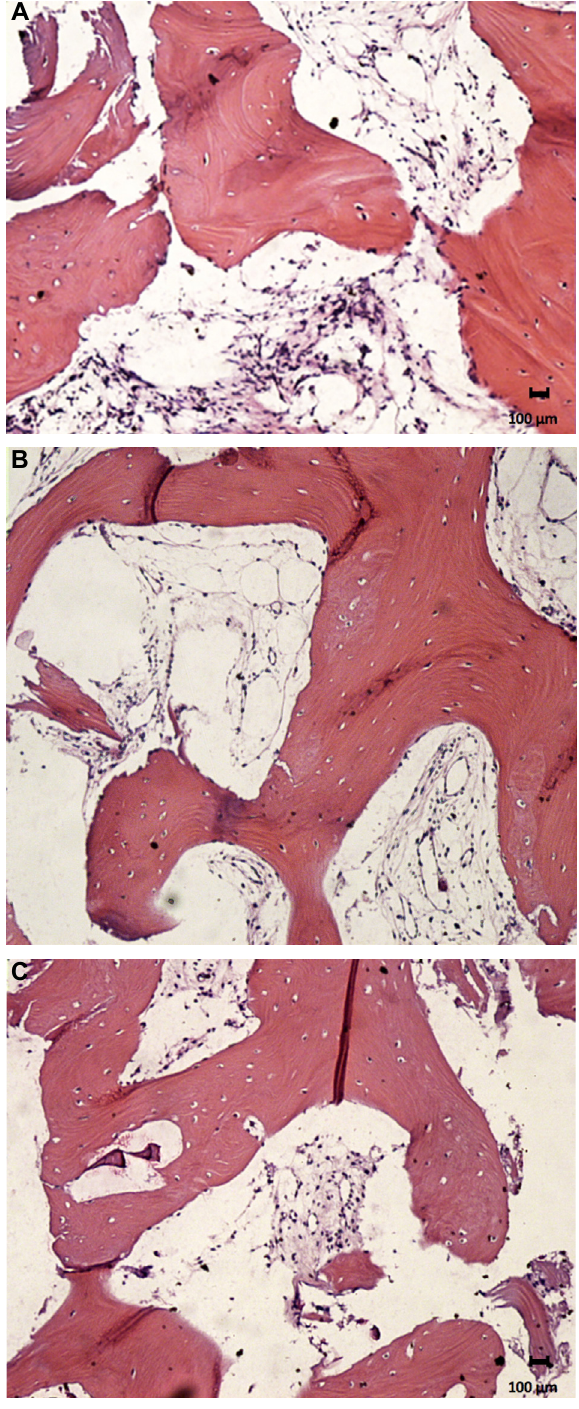
Figure 2- Image showing the histological section from group 1. A: Lamellar bone formation with a well cellularized connective tissue in the pristine bone region; B: Presence of lamellar bone formation and woven bone areas in the intermediate region; C: The new bone formation with an immature pattern in the apical region. Hematoxylin & eosin stain, x12.5 magnification